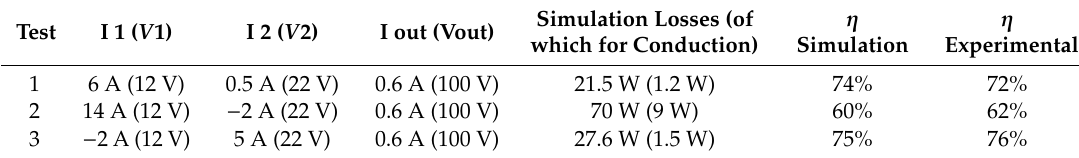
Table 4. Experimental test current values and e ffi